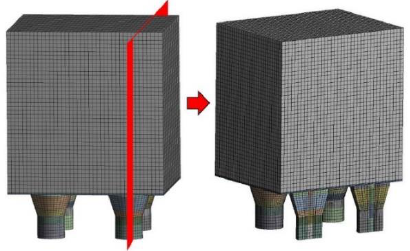
Figure 4. The mesh models. Table 1. Material properties